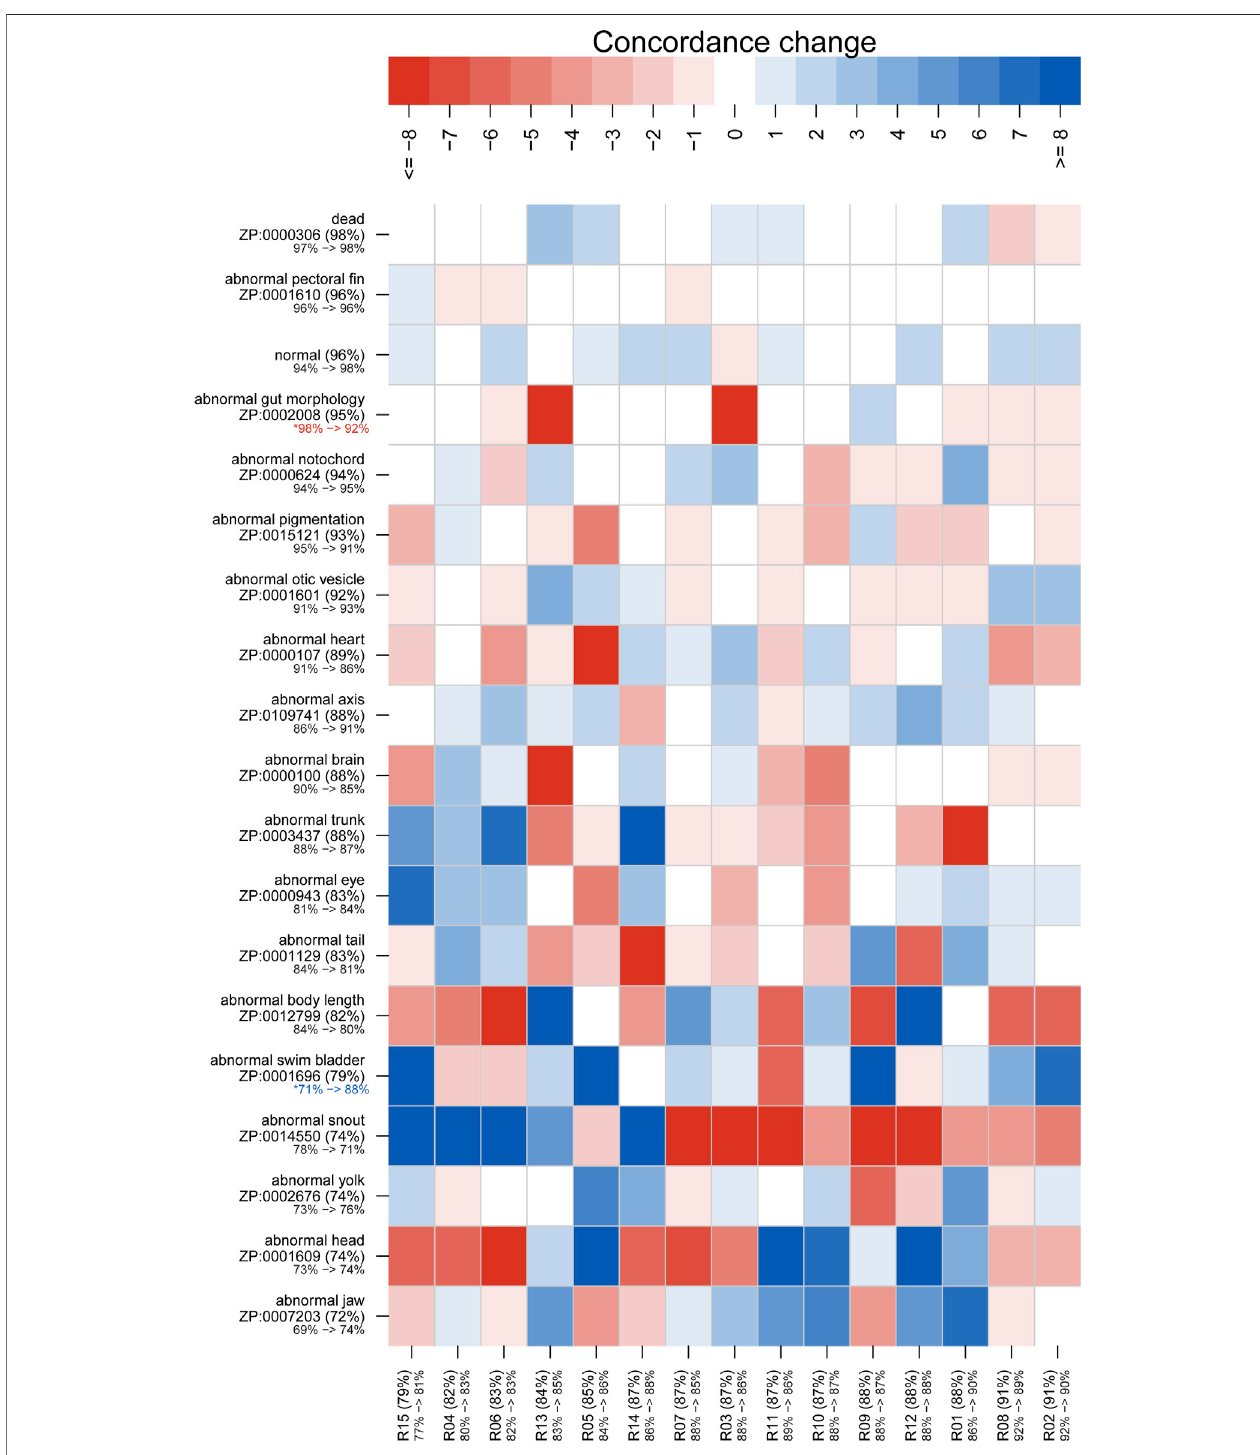
FIGURE 5 | Concordance change for general phenotype terms. Concordance here represents the frequency for which a particular rater (identi fi ed along x axis) made the same annotation as the majority of raters. The “ concordance change ” is calculated as the number of concordant annotations for Survey 1 subtracted from thoseforSurvey2(maximumrange isfrom − 24to24).Anincreaseinconcordanceisindicatedbyblueandadecrease isindicatedbyred.Boththeannotationandrater labelshavetheoverallmeanconcordanceforbothsurveysinparentheses,withacolor-codedchangeinmeanconcordancefromSurvey1toSurvey2below.Note that the lower bound for the annotation mean concordance is 50%, but the rater lower bound is 0%. Axes are sorted by overall mean concordance values. Signi fi cant changes in concordance as determined by Fisher ’ s exact tests are indicated by an asterisk.